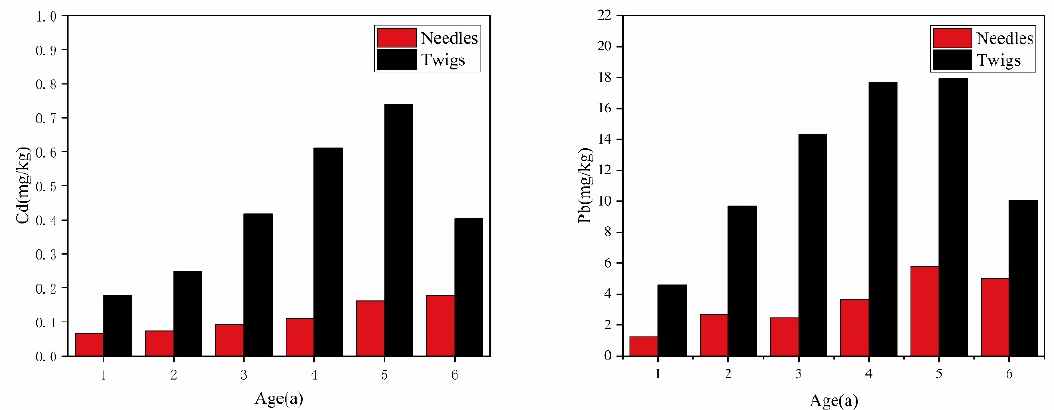
Figure 3. Pb and Cd in twigs and needles of different ages.